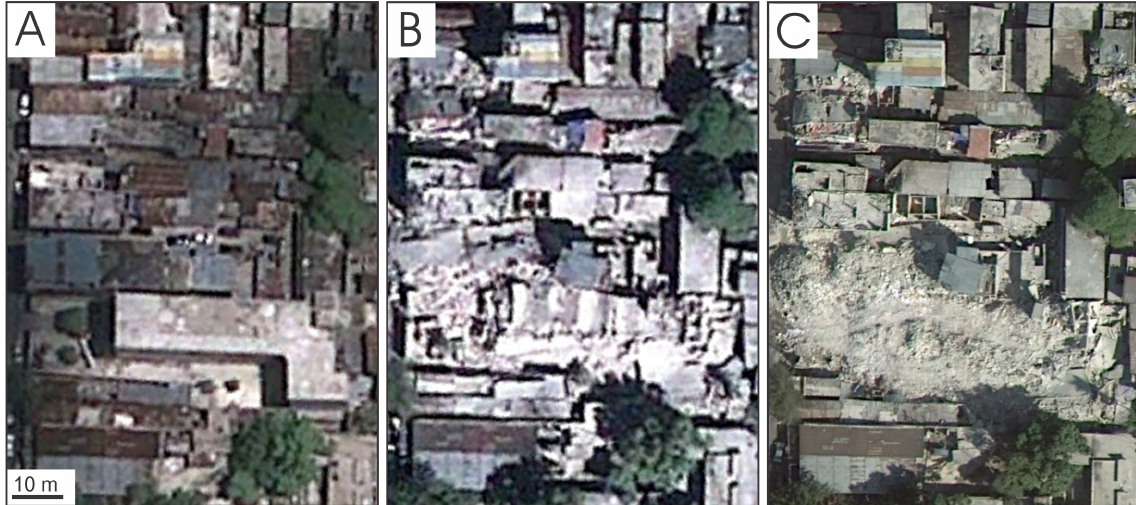
Fig. 2. Neighborhood in Port-au-Prince (Haiti) severely affected by the 12 January 2010 earthquake. Pre-event Geoeye-1 satellite image (26 August 2009; A ), first post-event satellite scene (Geoeye-1, 13 January 2010; B ), and airborne image acquired on 25 January 2010 (C) . ©Google